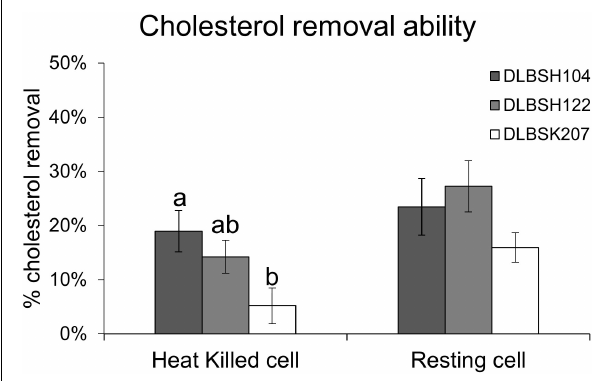
FIGURE 2 | Cholesterol removal ability of potential Lactobacillus strains in growing and non-growing state. Cholesterol removal ability of growing, resting, and heat-killed cells of 3 potential Lactobacillus strains was measured after incubation at 37 ◦ C for 24 h in media + 0.3% ox gall and cholesterol (100 mg/L). The result is expressed as mean ± SD of three independent experiments. Different letters a,b represent significant differences ( p < 0.05) for the comparison of all groups by one-way